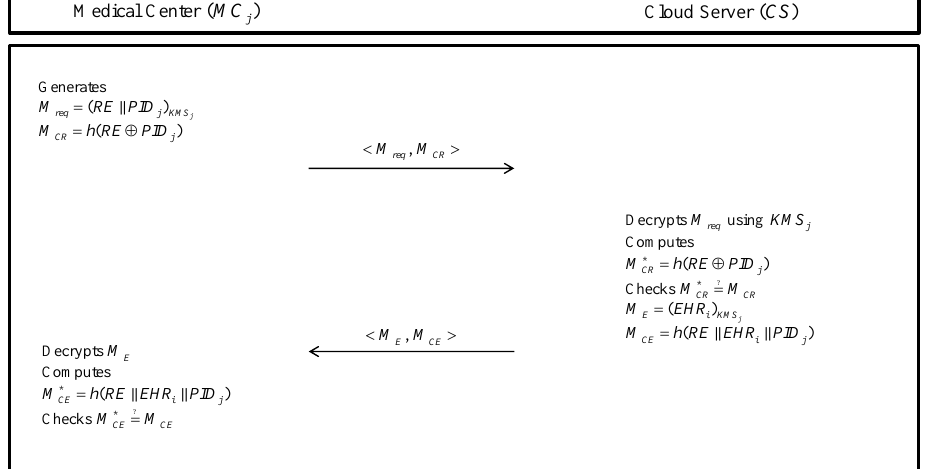
Figure 7. EHR requesting phase of the proposed protocol.